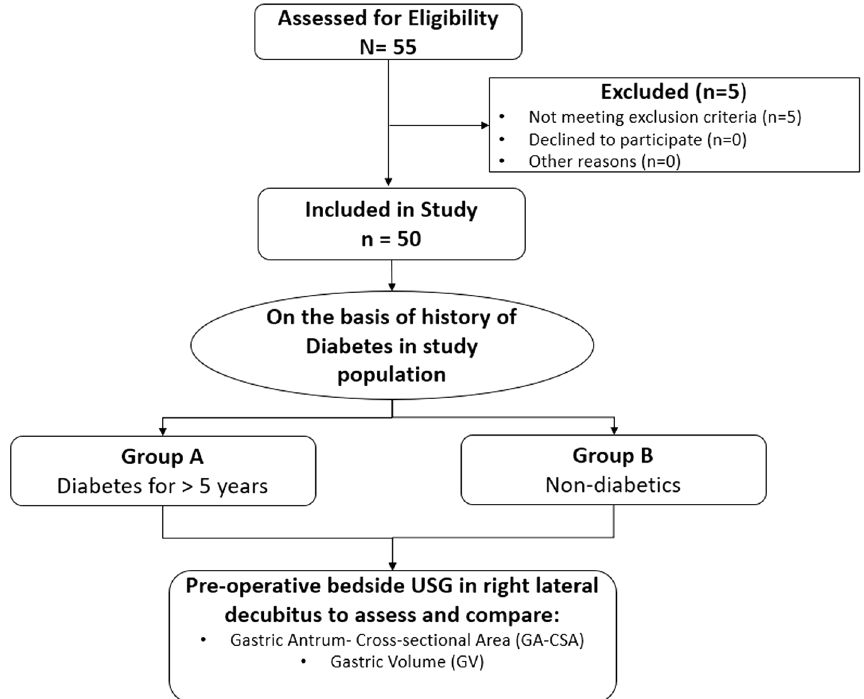
Fig. 2 CONSORT Flow Diagram for the